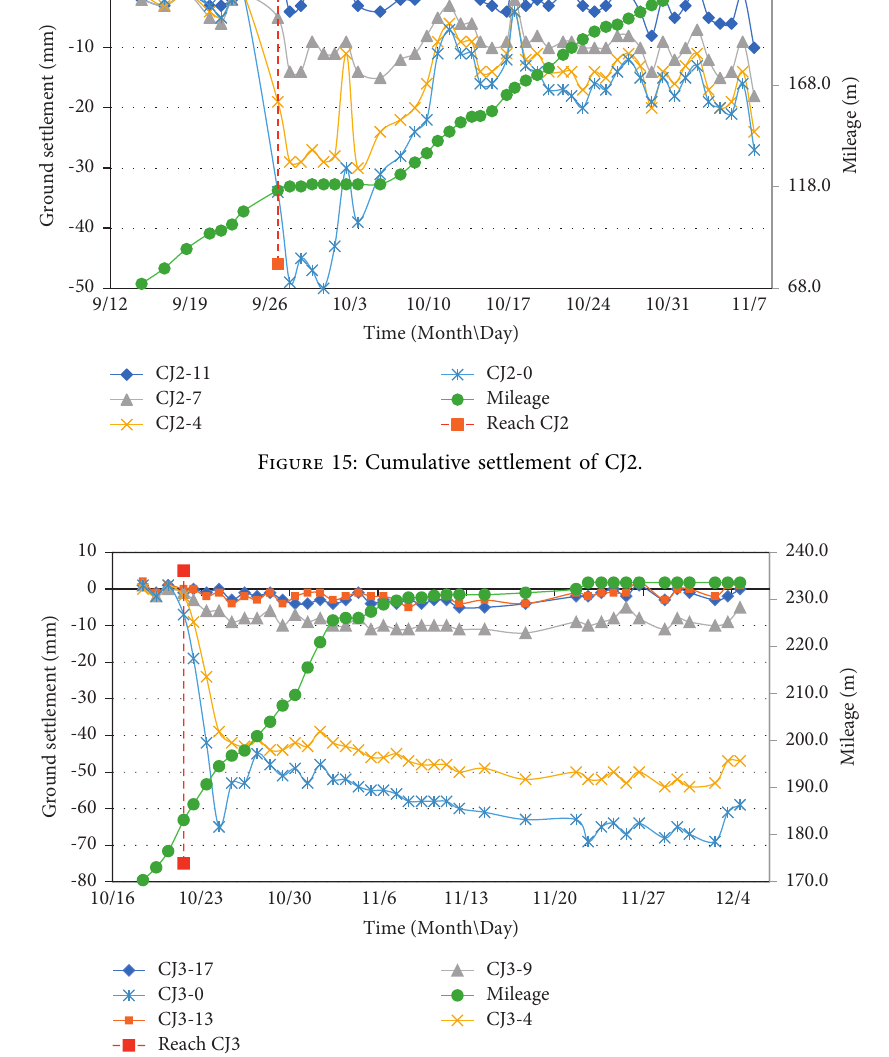
Figure 16: Cumulative settlement of